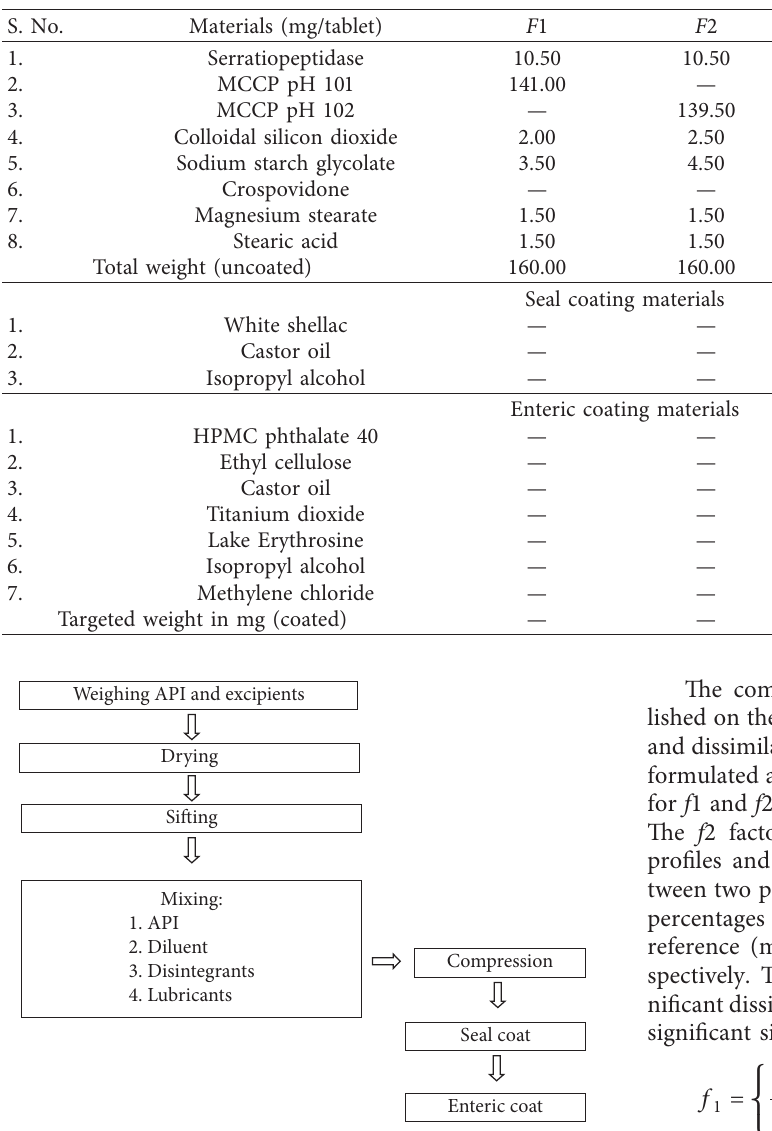
Table 1: Composition of formulated tablets.